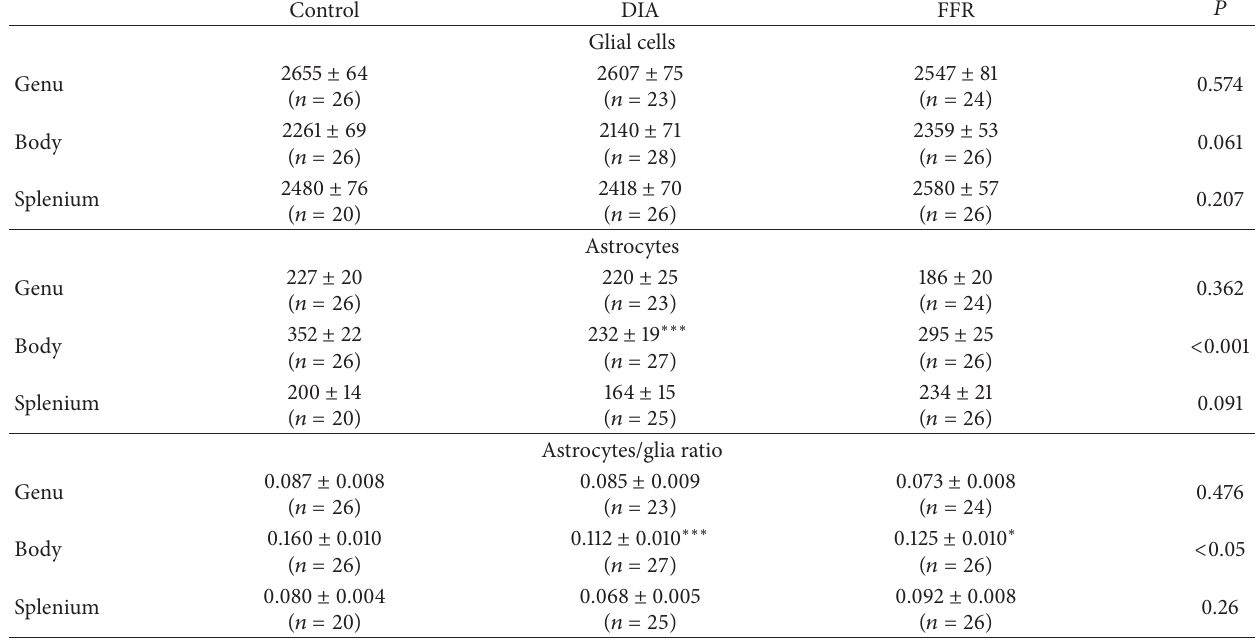
Table 1: Regional changes in glial cell density by DIA and